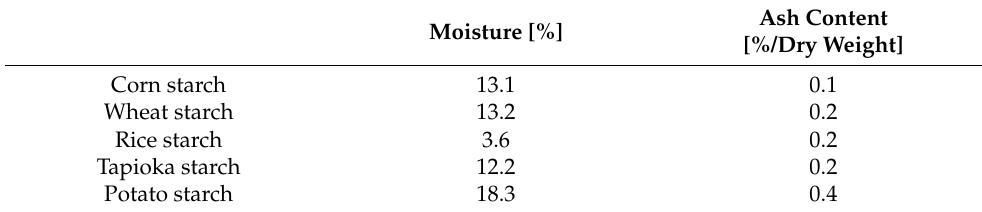
Table 1. Moisture and ash content of starches used for image analysis.